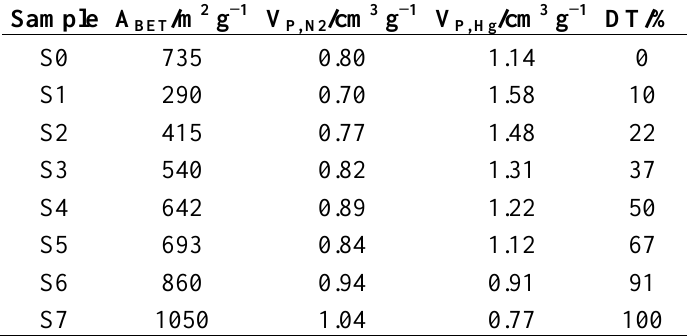
, obtained from nitrogen P